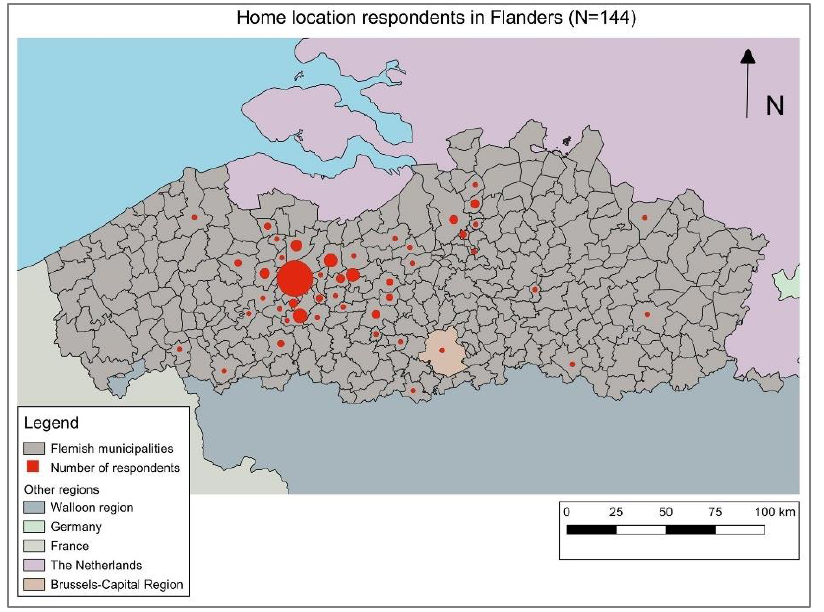
Figure 2. Home Location of Respondents